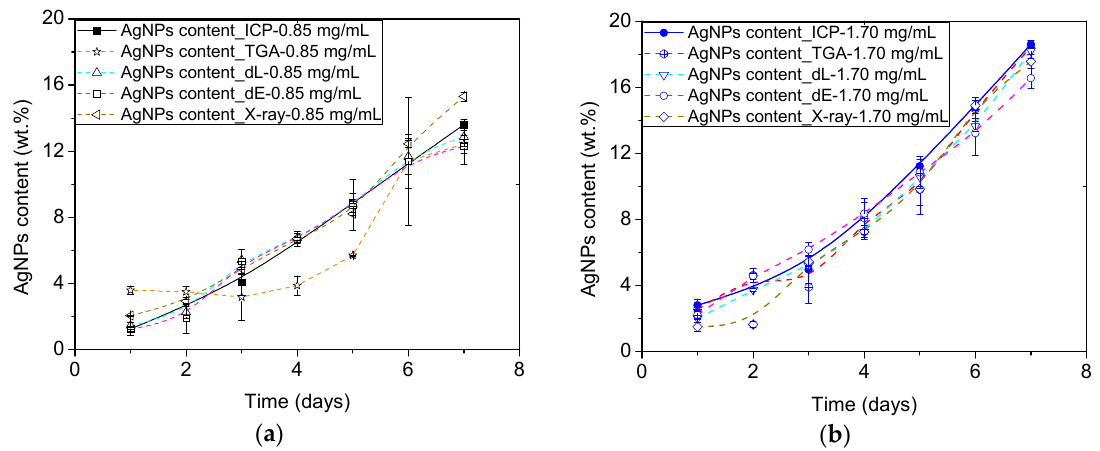
Figure 9. AgNPs contents of ME / Ag foams as a function of the reaction time using 0.85 mg / mL ( a ) and 1.70 mg / mL ( b ) as solution precursor.